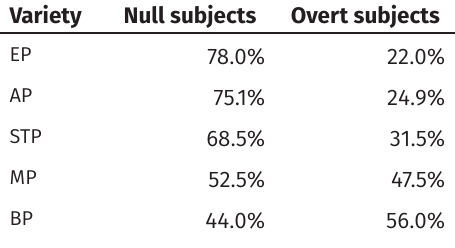
Table 9: SPE in European, Angolan, Santomean, Mozambican, and Brazilian